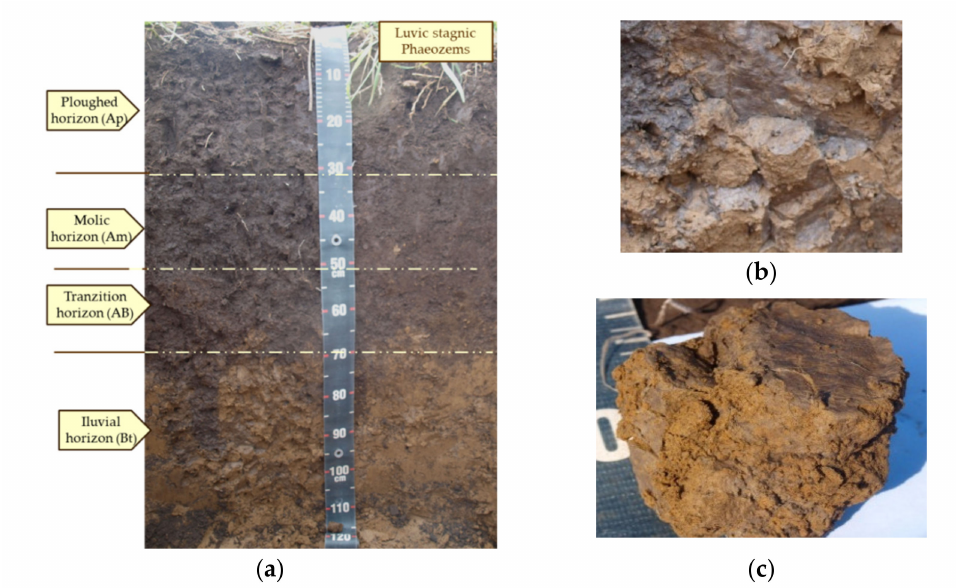
Figure 3. Profile of stagnic Phaeozems ( a ), complex clay-humic cutans on the faces of the structural aggregates ( b ), and fragment of prismatic aggregate with rediximorphic colors ( c